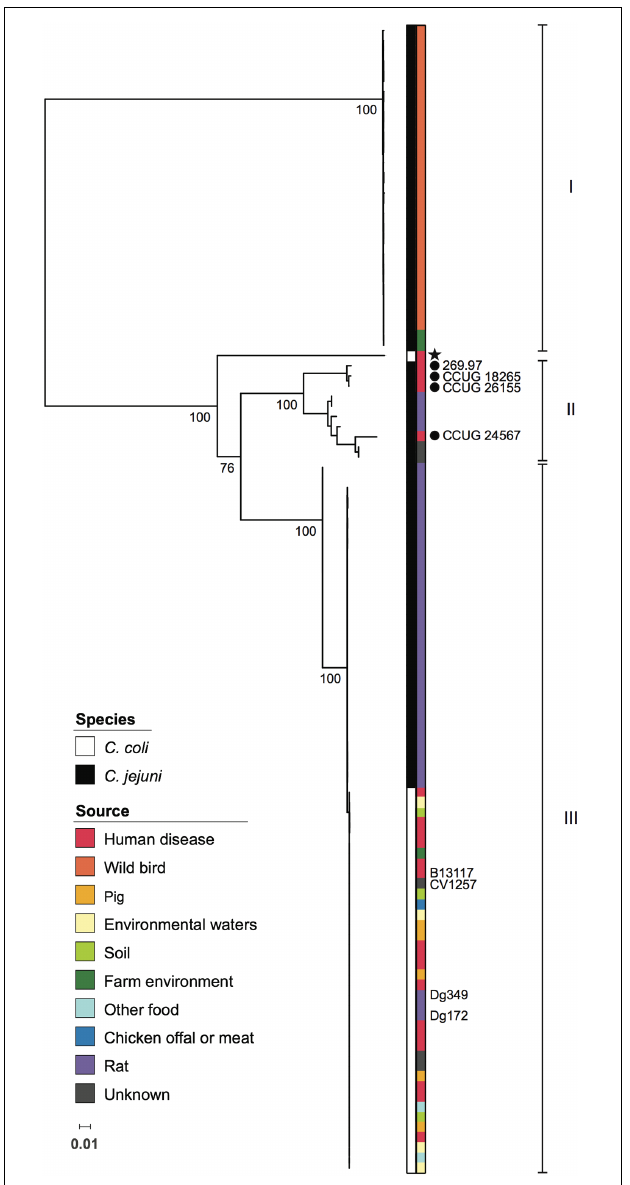
FIGURE 2 | Phylogenetic relationships among Campylobacter glc loci. Maximum likelihood tree based on concatenated nucleotide sequences of genes comprising the glc locus, encoding the Entner-Doudoroff pathway, from 113 Campylobacter isolates. Colored strips adjacent to the phylogeny indicate species and source as shown in the inset legends. Known C. jejuni subsp. doylei isolates are indicated with filled circles. All C. coli isolates were assigned to C. coli clade 1, with the exception of a single clade 3 isolate, which is marked with a star. Isolates included in experiments carried out in this study are labeled. Roman numerals indicate groups of glc sequences referred to in the text. For major nodes, bootstrap values generated from 500 replicates are shown as percentages. The scale bar represents the number of nucleotide substitutions per site.